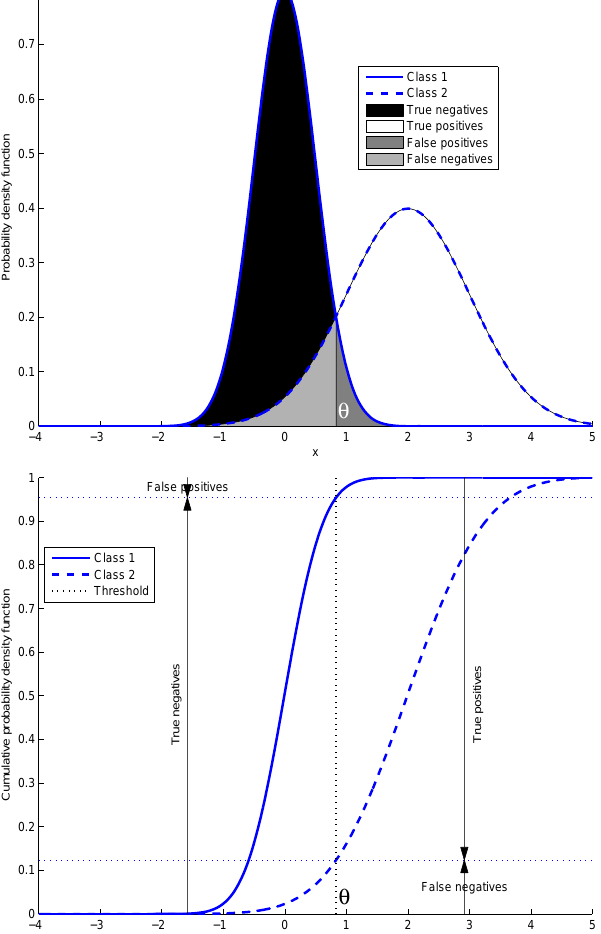
Figure 3. Visual representation of type I and II errors by density Fig. 3. Visual representation of Type I and II errors by density (top (top panel) and cumulative distribution (bottom panel) panel) and cumulative distribution (bottom panel) functions.